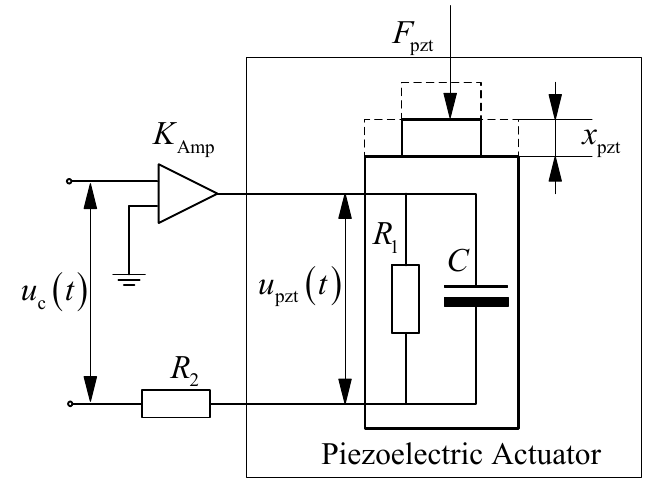
Figure 2. Equivalent driving circuit of the piezoelectric actuators